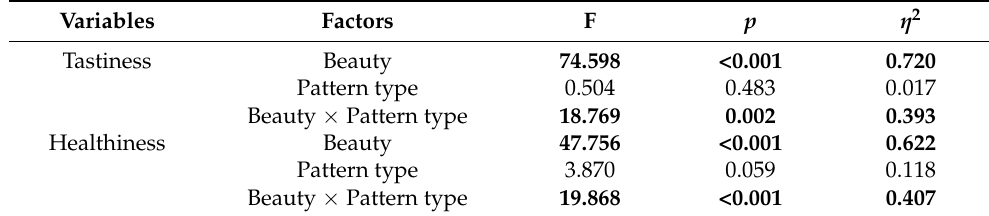
Table 1. Repeated measures ANOVA in Experiment